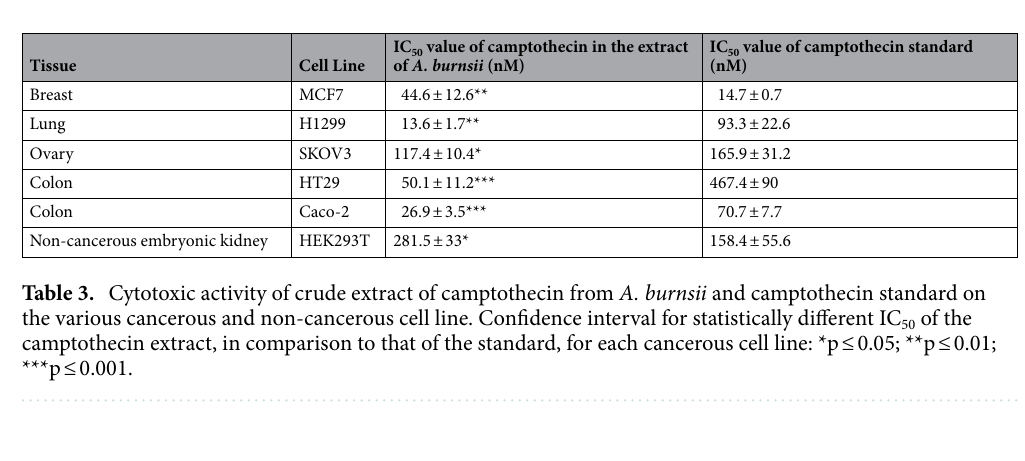
IC 50 value of camptothecin standard